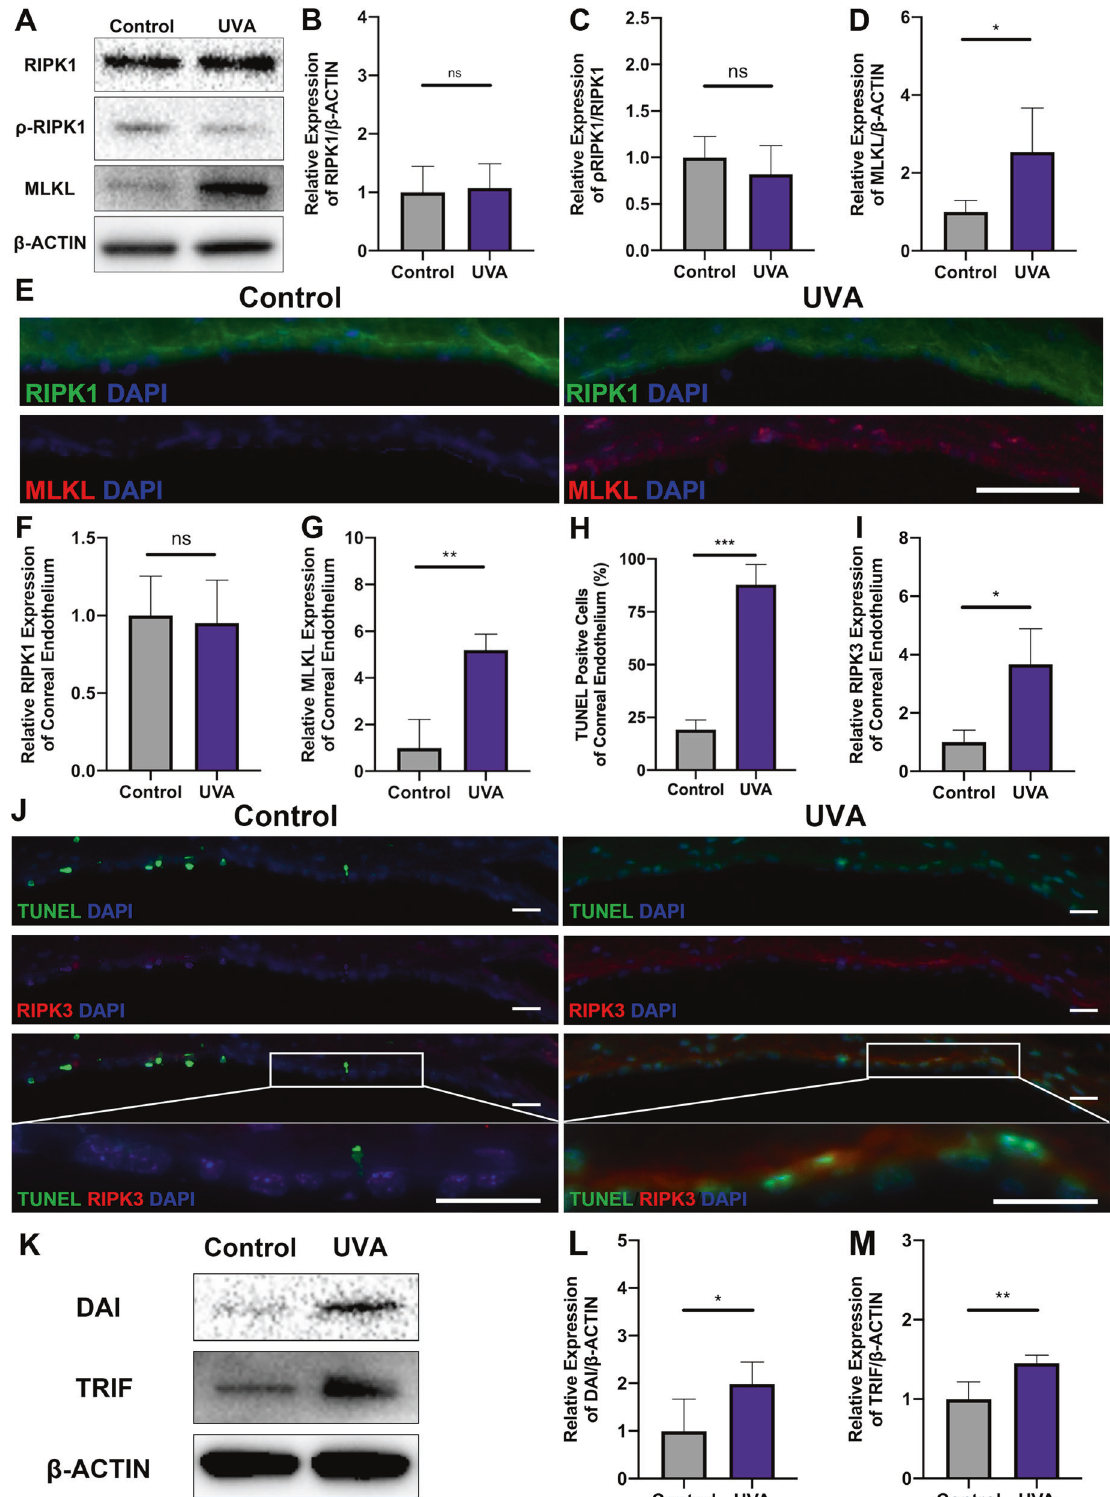
Fig. 2 High-dose UVA induced necroptosis, which is not related to RIPK1 in mouse CE. A – D Western blot analysis of RIPK1, ρ -RIPK1, and MLKL in mouse CE. n = 4 per group. E Representative immuno fl uorescence images of RIPK1 (Green), MLKL (Red), and DAPI (Blue) localization in mouse CE with control and UVA irradiation (Scale Bar: 50 μ m). F, G The fl uorescence intensity of RIPK1 and MLKL under UVA irradiation was compared based on the control group ( n = 3 per group). H – J TUNEL (Green) and RIPK3 (Red) co-staining after UVA irradiation (Scale Bar: 10 μ m). Necroptotic was analyzed by measuring the TUNEL-positive cells (%) and the fl uorescence intensity of RIPK3 in mouse CE ( n = 6 per group). K – M Western blot analysis of DAI and TRIF in mouse CE ( n = 4 per group). Statistical signi fi cance was analyzed with the unpaired Student ’ s t -test . ** P < 0.01, *** P < 0.001 , **** P < 0.0001 . All values are expressed as mean ±